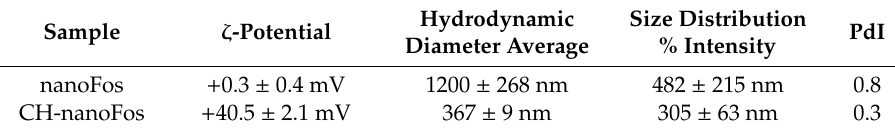
Table 1. DLS parameters of nanoFos and CH-nanoFos in deionized water (average data of three experiments).